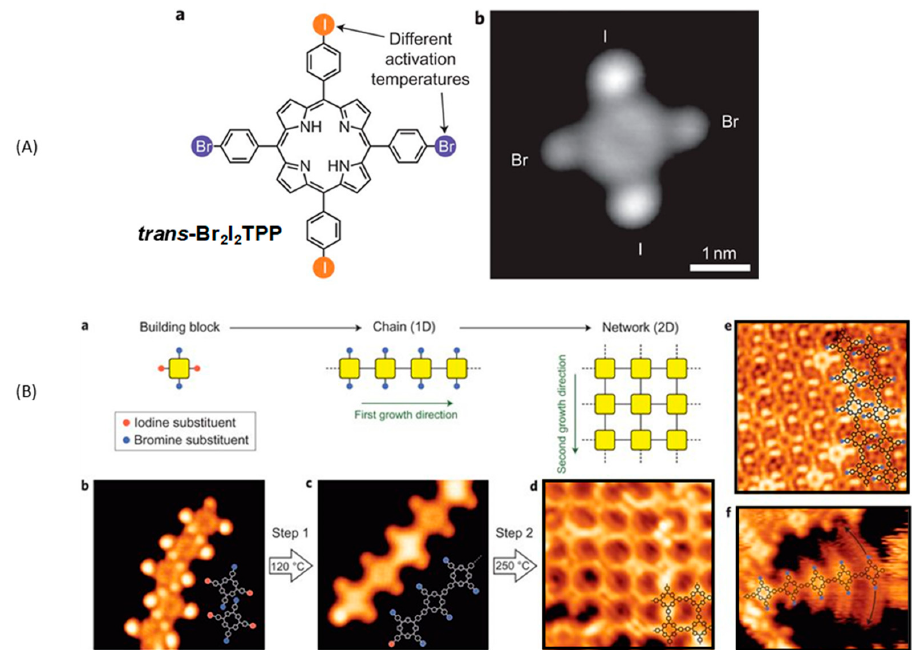
Figure 5. Sequential growth of a 2D architecture with 5,15- bis (4 ′ -bromophenyl)-10,20- bis (4 ′ -iodophenyl)porphyrin ( trans -Br 2 I 2 TPP). ( A ) Chemical structure of the precursor. ( B ) Two-step polymer growth. Reprinted by permission from Macmillan Publishers Ltd: Nature Chemistry from [83], copyright